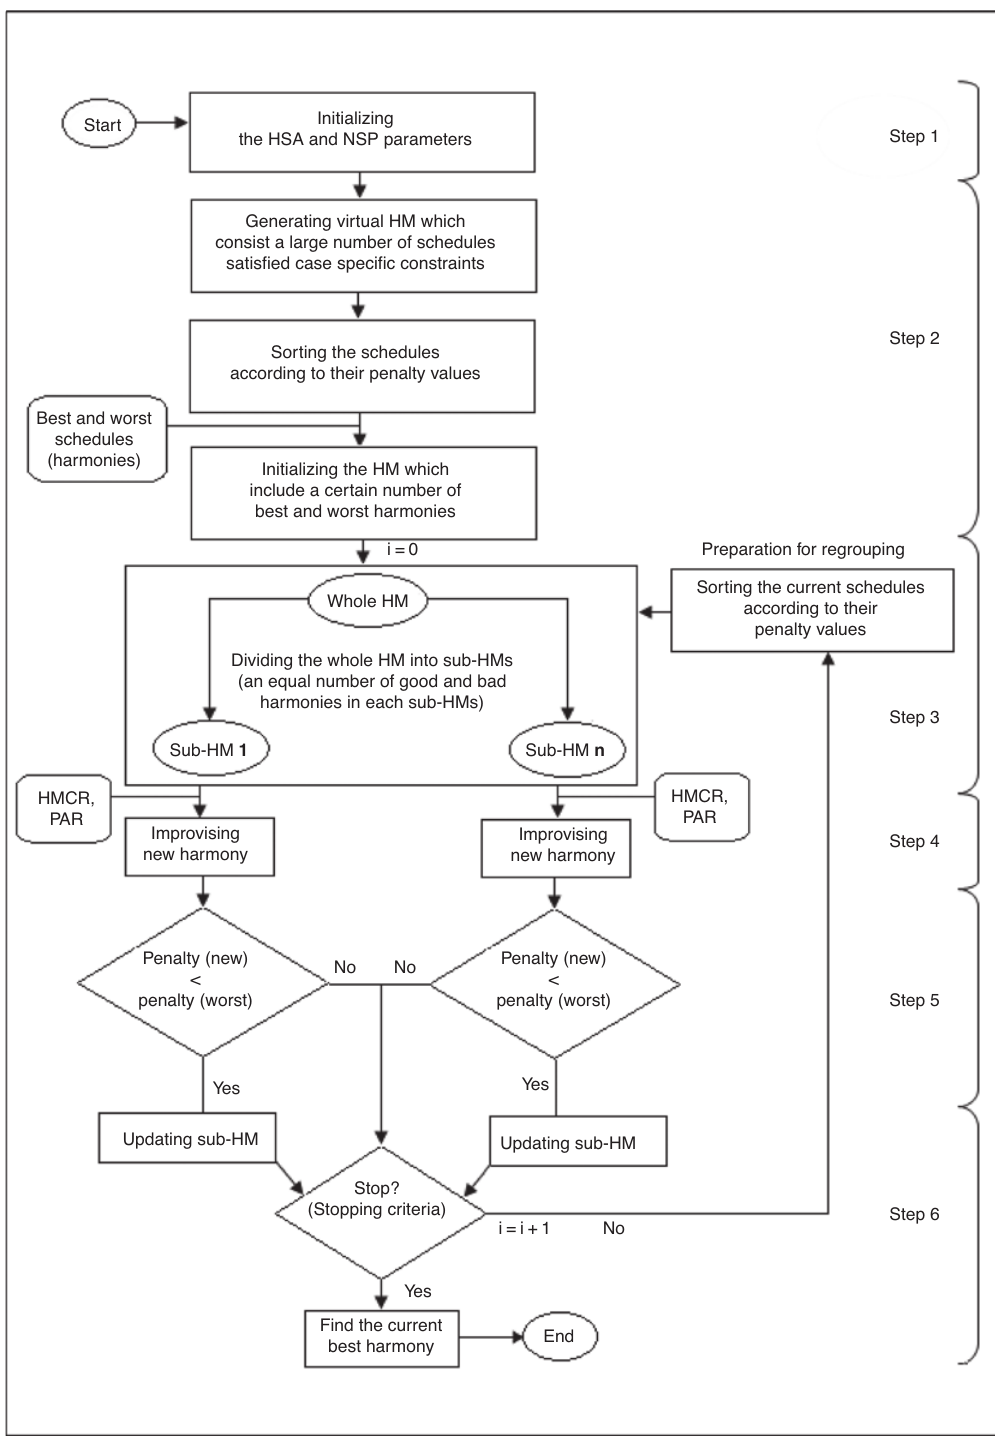
Figure 5: Flowchart of the Proposed Parallel HSA [8].